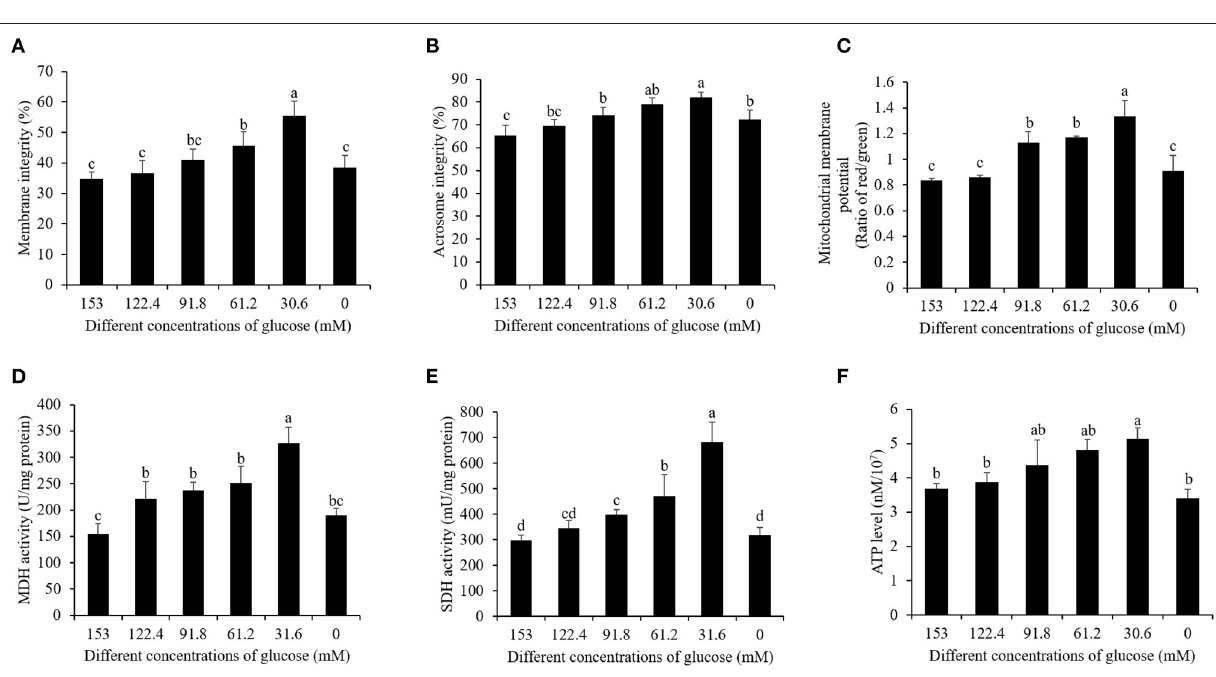
contains three distinct regions, namely, head, mid-piece, and